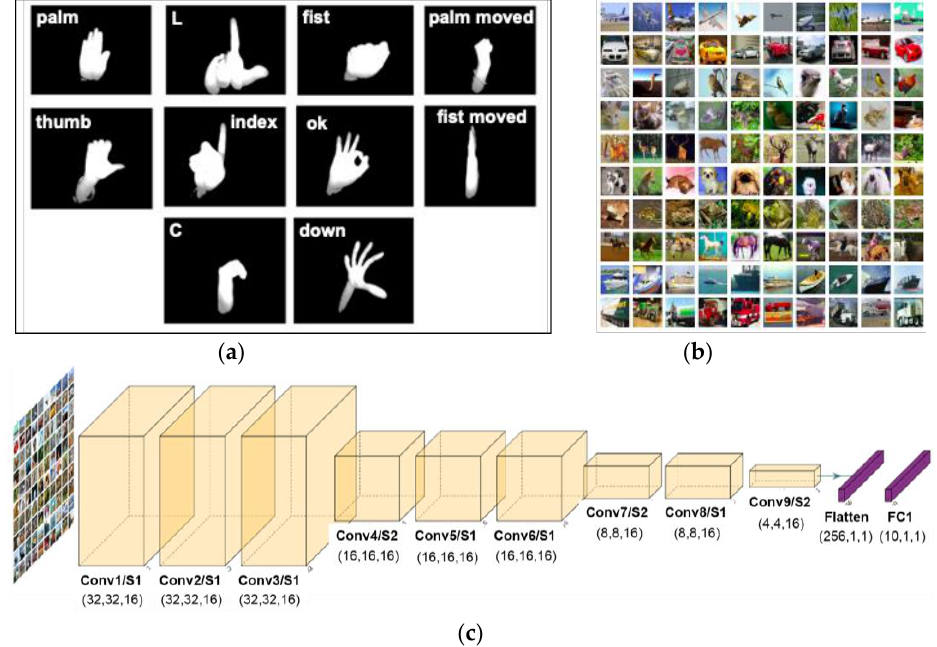
Figure 3. ( a ) Hand gesture datasets; ( b ) CIFAR-10 datasets. ( c ) The developed tiny CNN